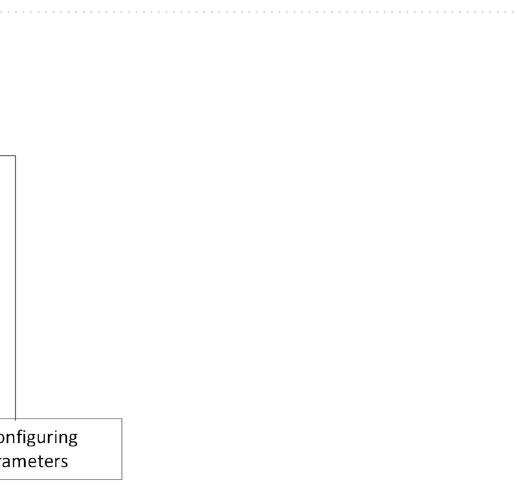
Figure 6. Design and testing of circuit system. ( a ) Block diagram of hardware platform; ( b ) Testing of adaptive control circuit.